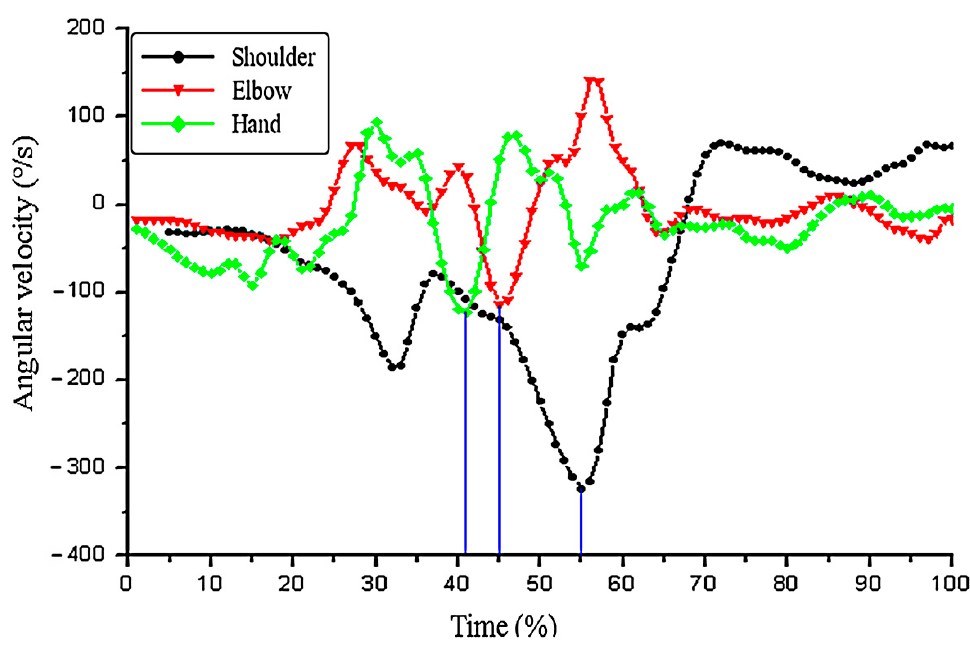
Figure 6. Angular velocity change in the shoulder–elbow–hand joints in the master group ( n = 7).